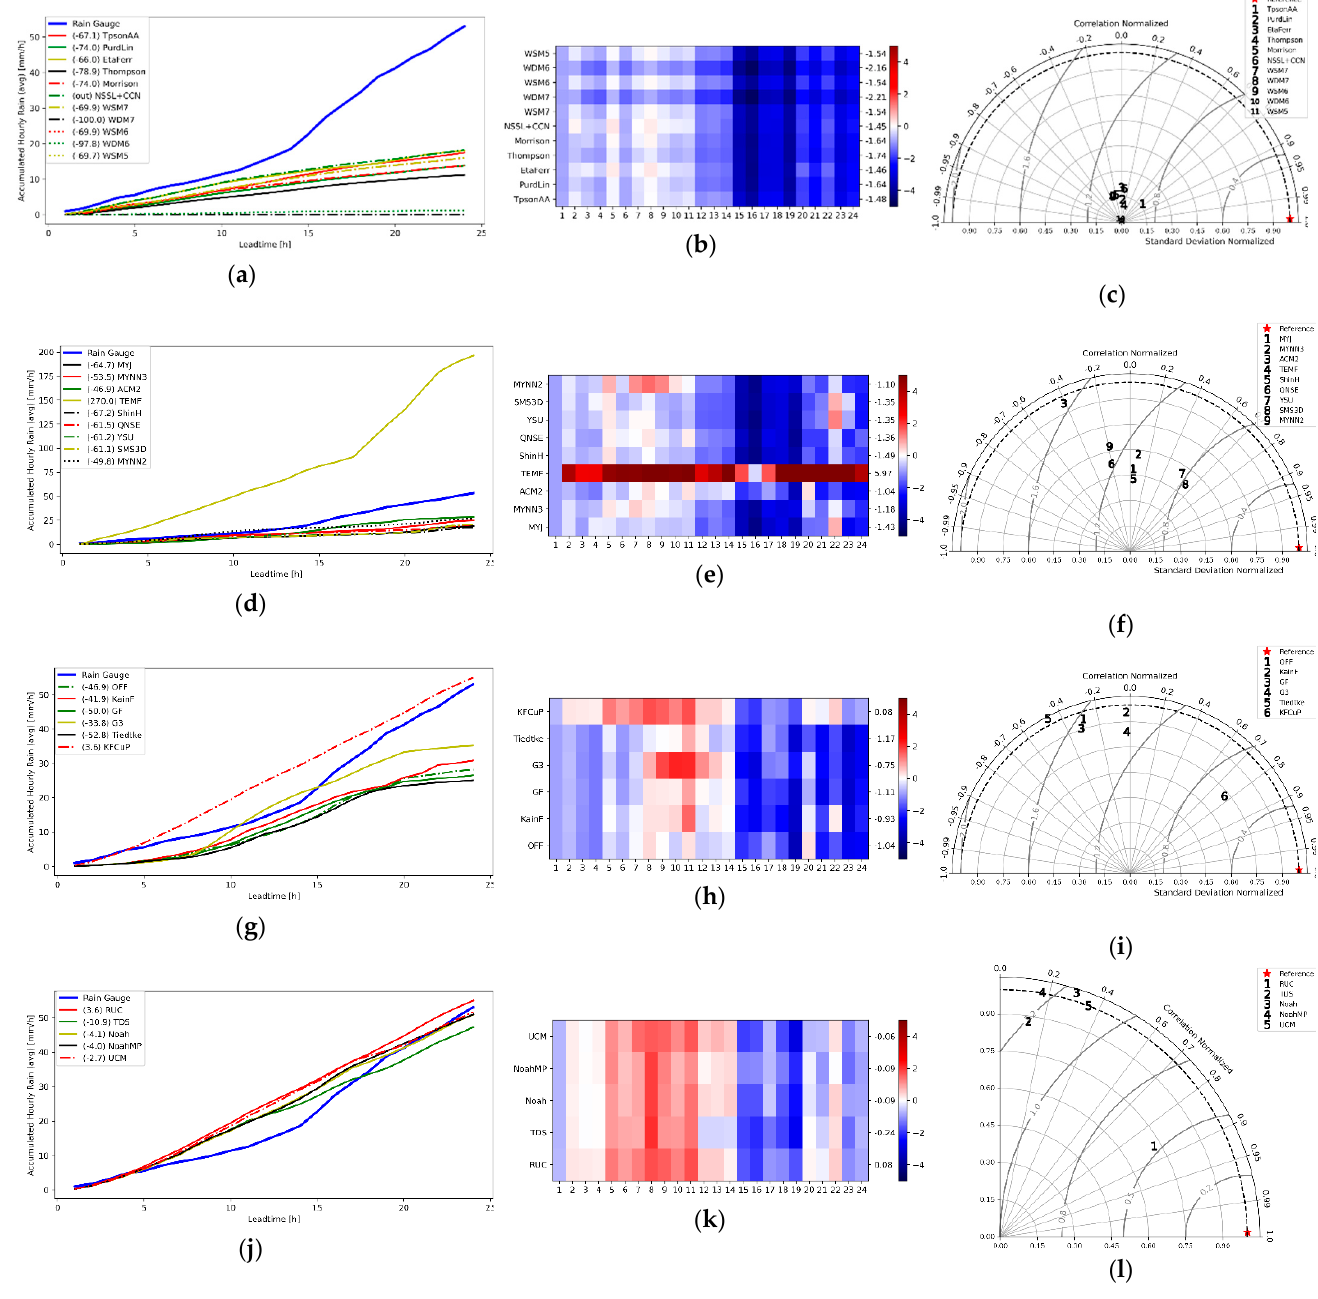
Figure 5. As in Figure 4 but for event 2.